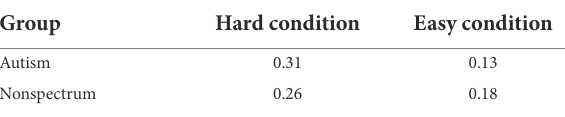
TABLE 2 Proportion of modifiers that were postnominal as compared to prenominal produced by parents by condition and group (trials with no modifiers or with both pre- and postnominal modifiers were